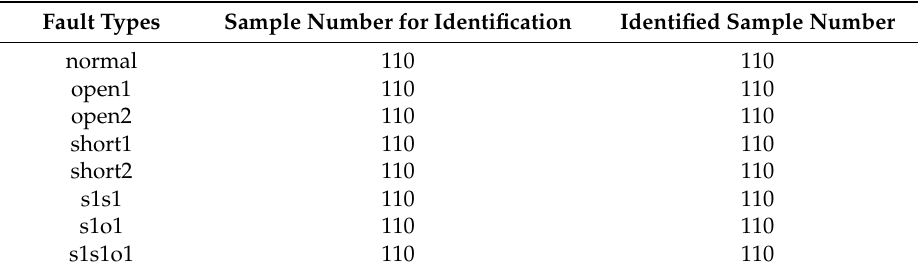
Table 5. Eight fault identification accuracy in testing phase of simulation experiment.